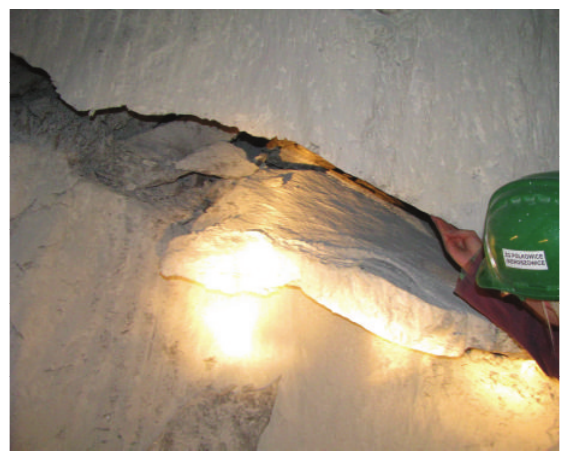
Figure 12: Crack in the contact zone of rock salt (a) and anhydrite (b) in the side wall of the Ps-1 gallery